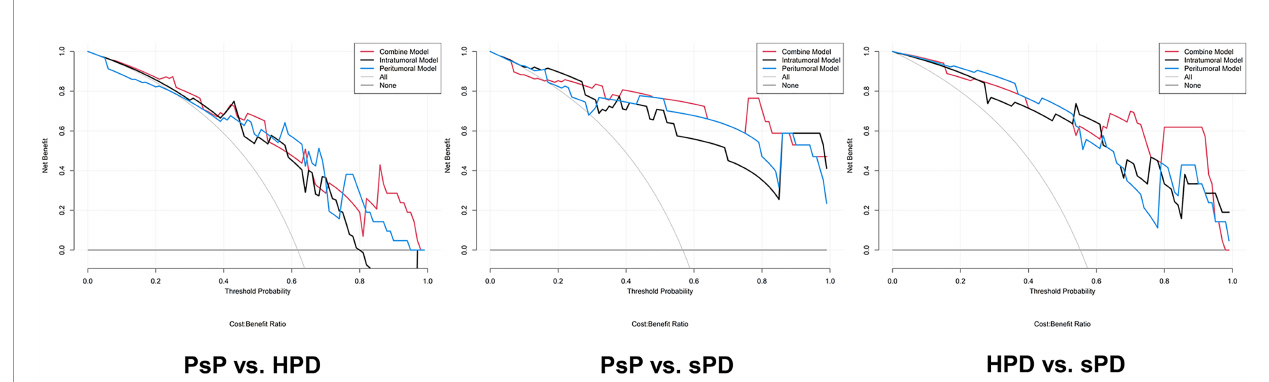
FIGURE 6 | Decision curve analysis for the radiomics signatures in the testing datasets. The result of the decision curve analysis indicated that the prediction of PsP and HPD using the combined RS can give more net bene fi t than by treating none or all patients in both training and testing